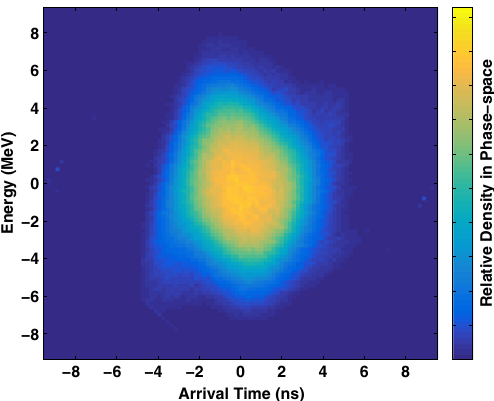
FIG. 14. Tomography measurements of longitudinal distribu- tion of beam injected into the Recycler. Distribution derived from an average across Booster batch. Measurement taken from a typical 2 þ 6 slip stacking cycle on May 27th 2015 at a bunch intensity of 5 . 1 × 10 10